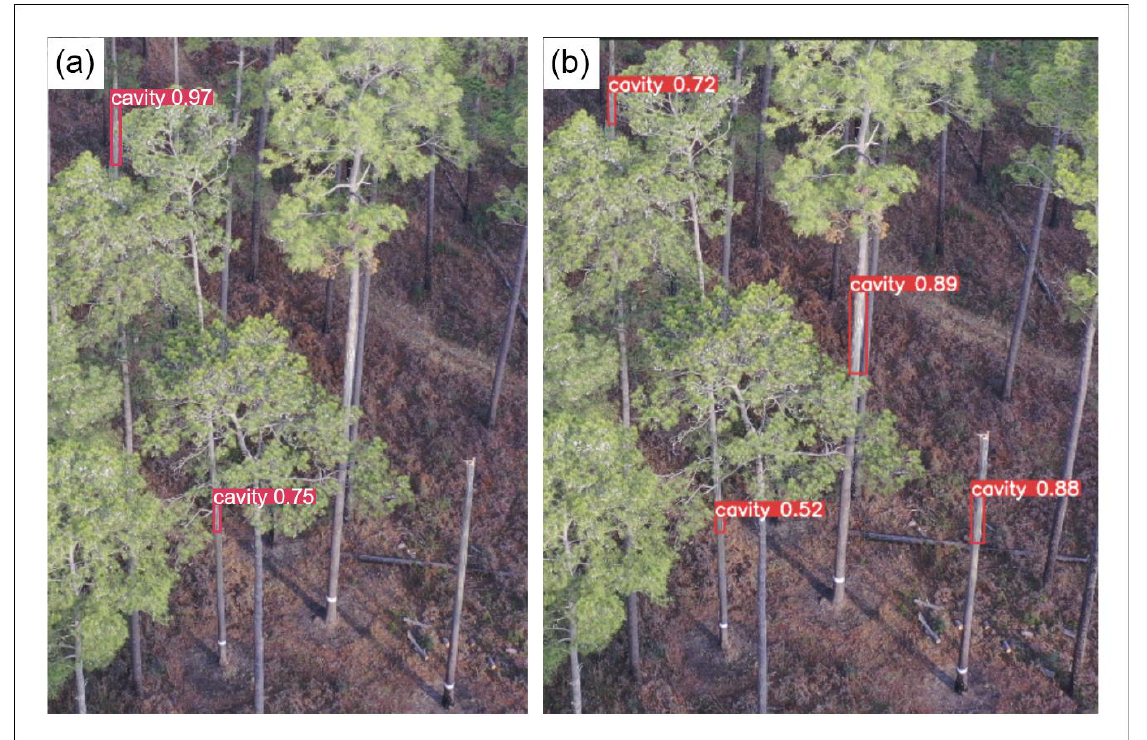
Figure 7. Inference result on one image taken at 76 m altitude by ( a ) YOLOv4-tiny and ( b ) YOLOv5n. While all the cavity trees in test images were collectively detected by the models, some examples were uniquely detected by only one model. Specifically, YOLOv5n detected two cavities, while YOLOv4-tiny was not able to detect them.